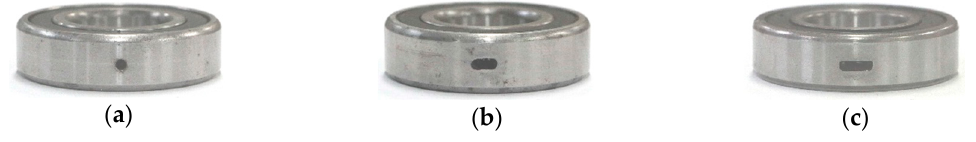
Figure 10. Bearings with different spall length: (a) Δ Φ d =5°; (b) Δ Φ d =10°; (c) Δ Φ d =15°.